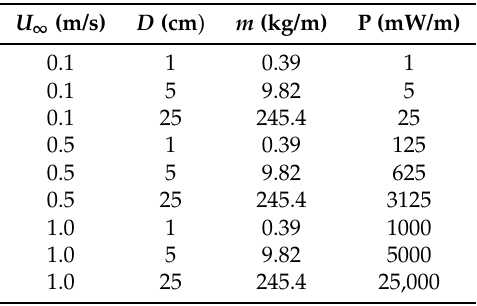
Table 3. Estimated power output per unit span of the cylinder generated by the novel hydro-kinetic energy